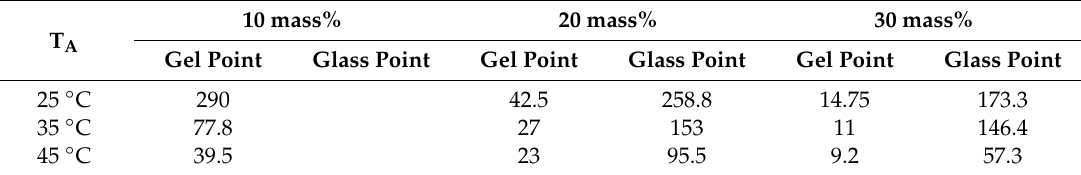
Table 2. Glass and gel points for the waterglass samples with added AlPO 4 .